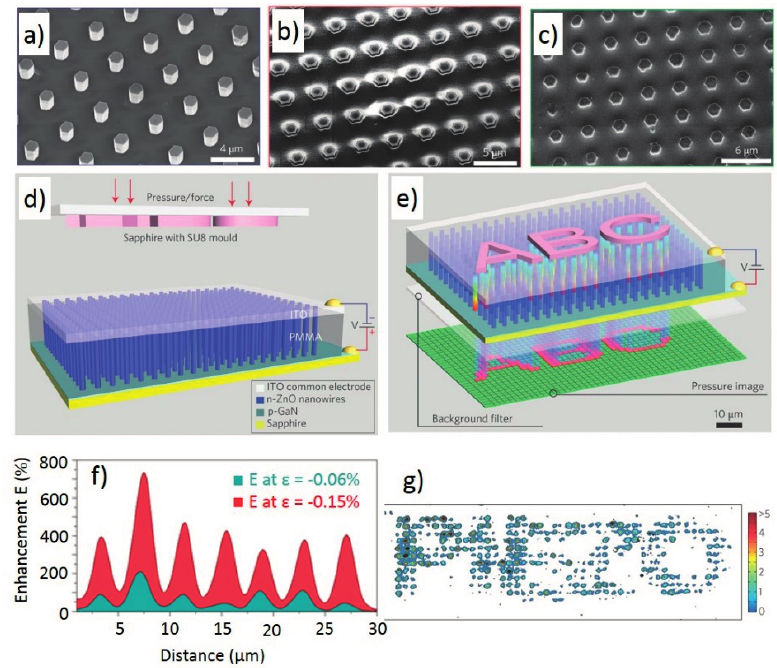
Figure 4. SEM images of hydrothermally grown ZnO nanowire arrays ( a ) on GaN substrate; ( b ) infiltrated with PMMA and etched to expose tips and ( c ) with ITO top electrode deposited; ( d ) Illustration of device cross section and testing procedure, and resulting image ( e ) from applied pressure; ( f ) Enhancement factor for a subset of an LED row at − 0.06% and − 0.15% strain. Peaks correspond to LED locations; ( g ) Spatial map of enhancement factor resulting from imprint of the “PIEZO” text stamp on the sensor. Adapted by permission from Macmillan Publishers Ltd: Nature Photonics [64] Copyright 2013.